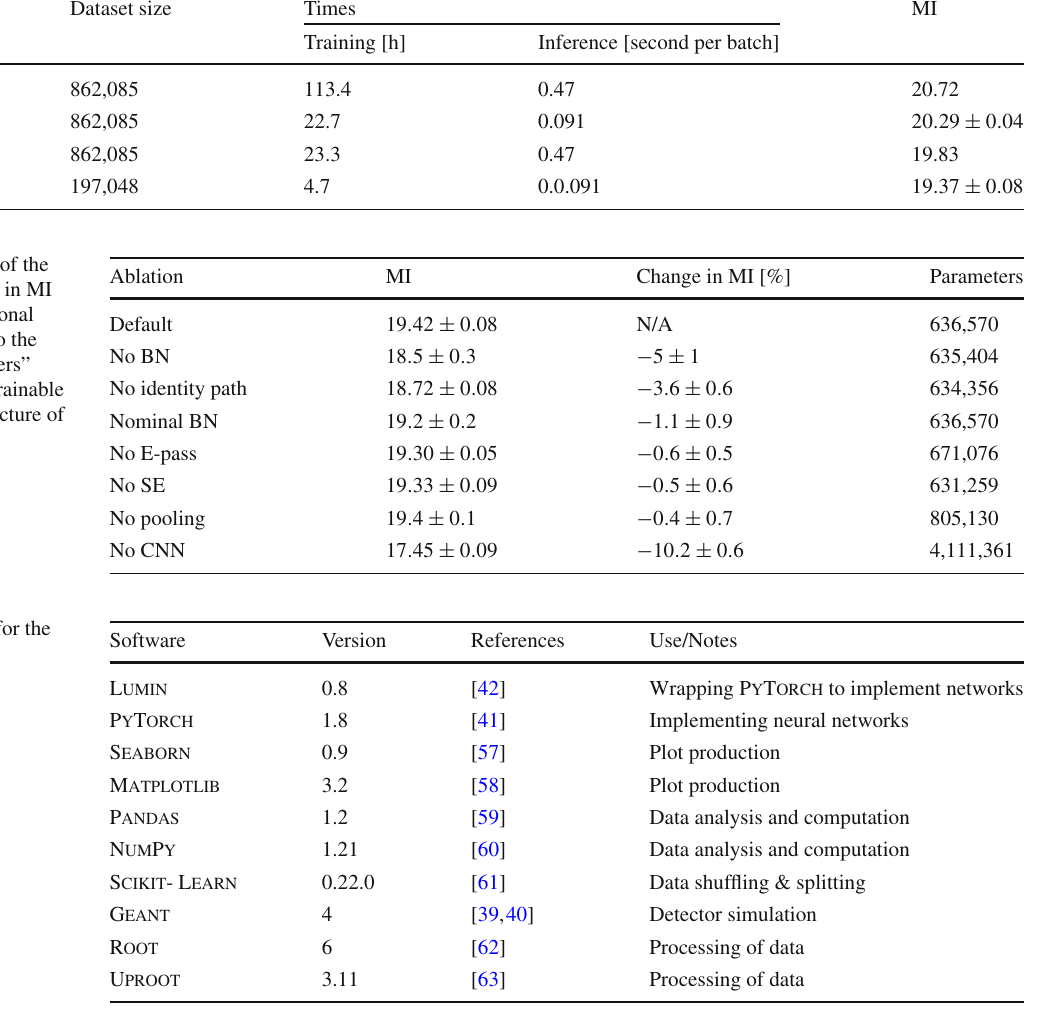
Table 3 Ablation study of the ensembling and dataset size and usage. Inferencetimeisperbatchof256muonsandexcludesthedisk-to-RAM time. The MI is computed on the holdout-validation data. “Full” indi- cates the model was trained on 34/36 folds of data and monitored on